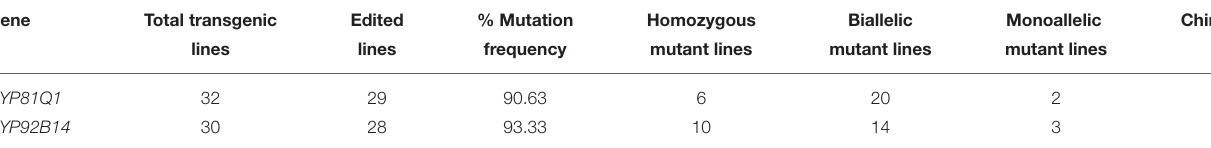
TABLE 1 | Summary of mutations in transgenic hairy roots.